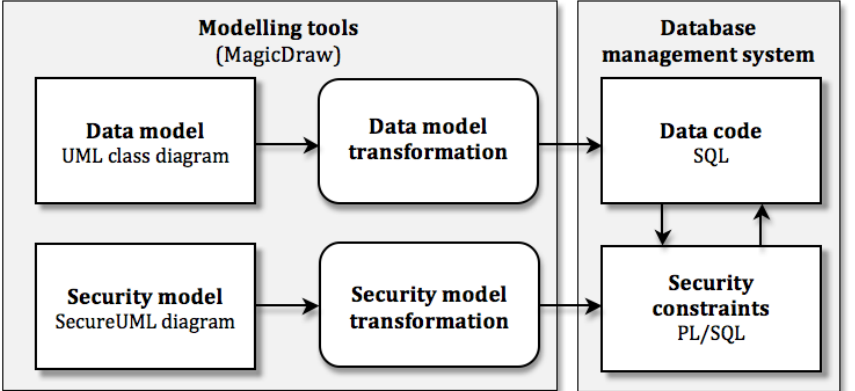
Figure 5. Data and Security Model